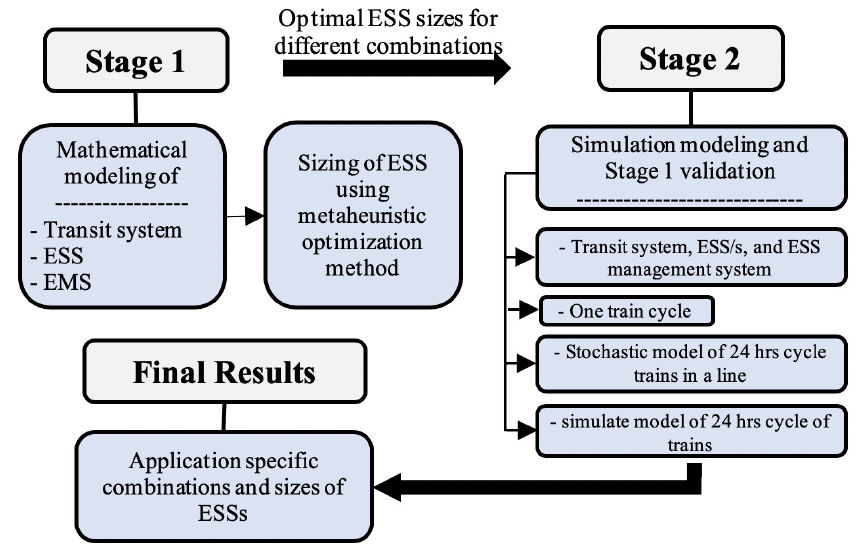
Figure 1. Optimization of WESS using a two-stage